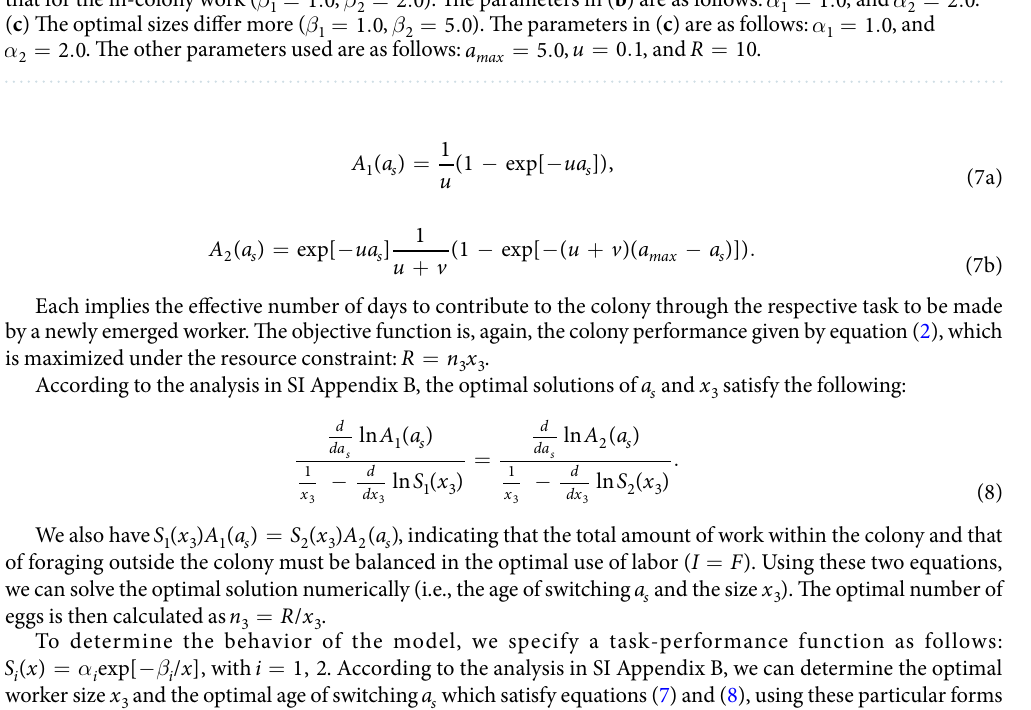
, and α = . 2 0 . 1 2 , and 1